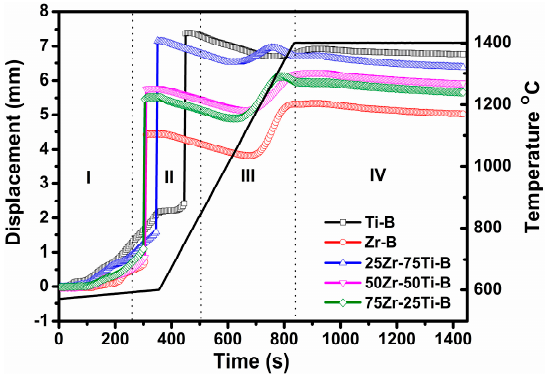
Figure 4. Sintering behavior at 1400 °C with 50 MPa applied pressure and 50 °C/min heating rate.